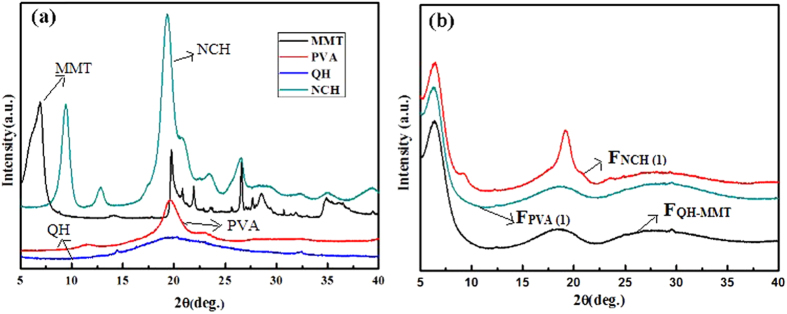
The XRD patterns of MMT, QH, PVA, NCH (a), and the three composite films (FQH-MMT, FNCH(1), and FPVA(1)) (b).